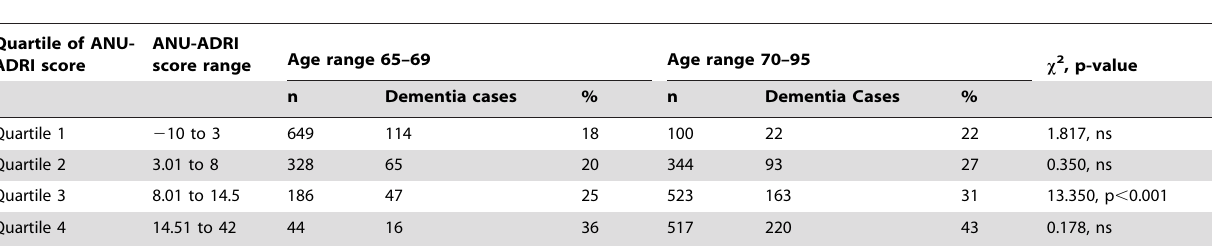
Table 5. Dementia cases per quartile score on the ANU-ADRI for young-old and old-old in the CVHS study.